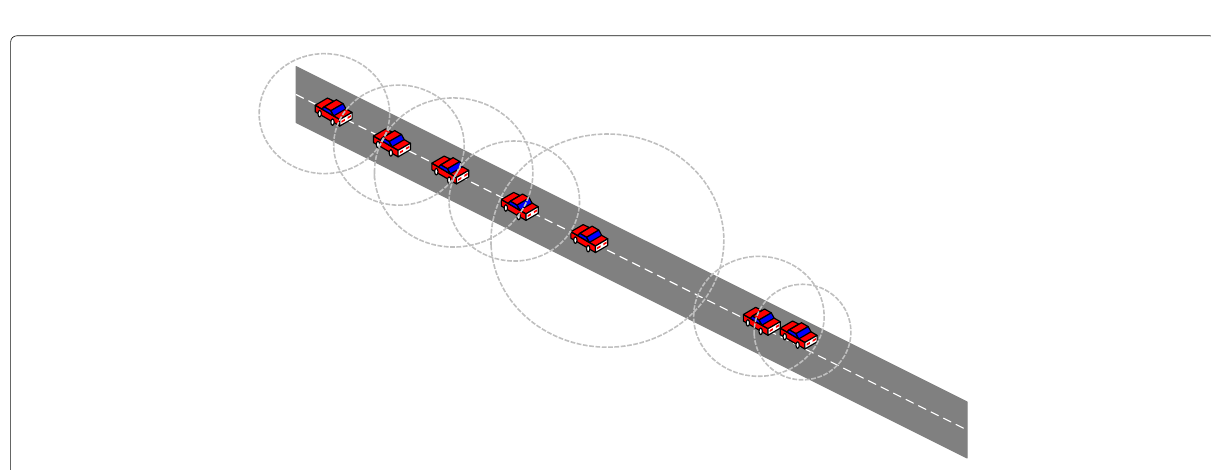
Fig. 8 First experiment to evaluate the X-MAC